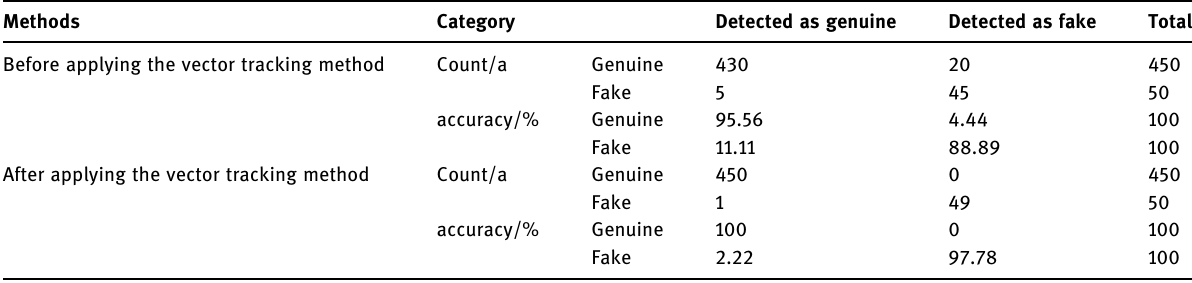
Table 1: Tobacco supply chain trace source anti - counterfeiting test results